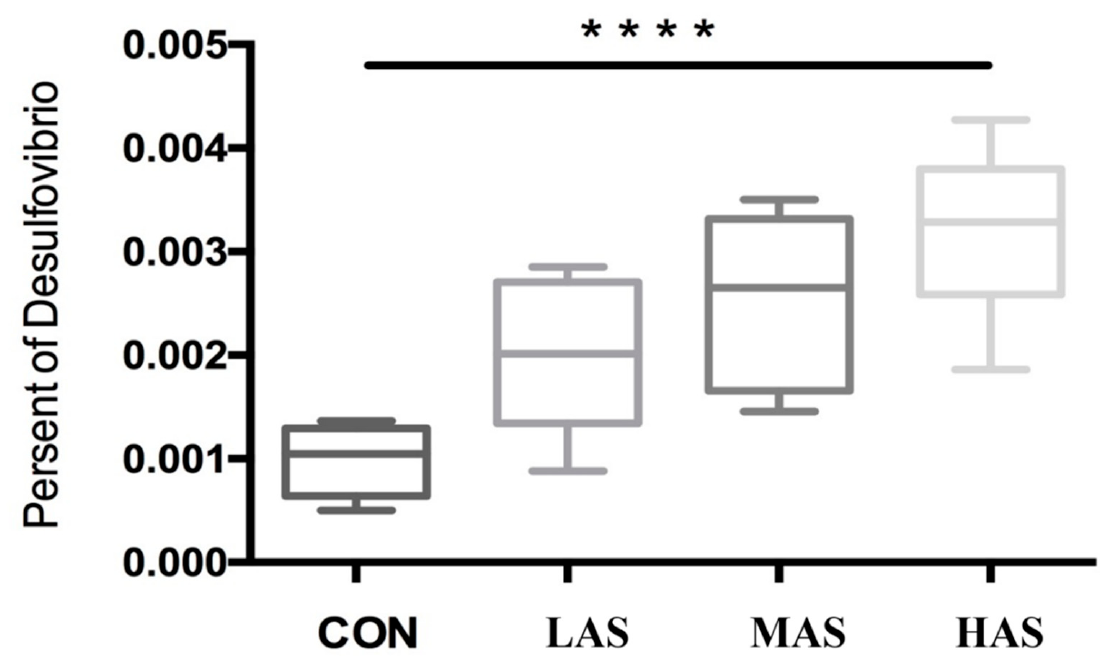
Figure 5. Difference test of bacterial communities in the phylum ( A ) and genus ( B ) level in different groups. CON-S (%DM) 0.4%; LAS-S (%DM) 0.6%; MAS-S (%DM) 0.8%; HAS-S (%DM) 1.0%. Aster- isk means significant difference between treatments.